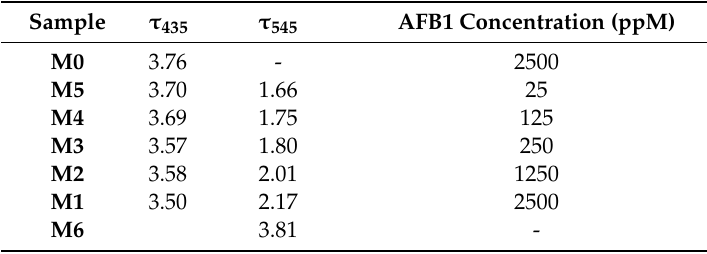
Table 2. Fluorescence lifetimes of AFB1-CdSe / ZnS samples with di ff erent AFB1